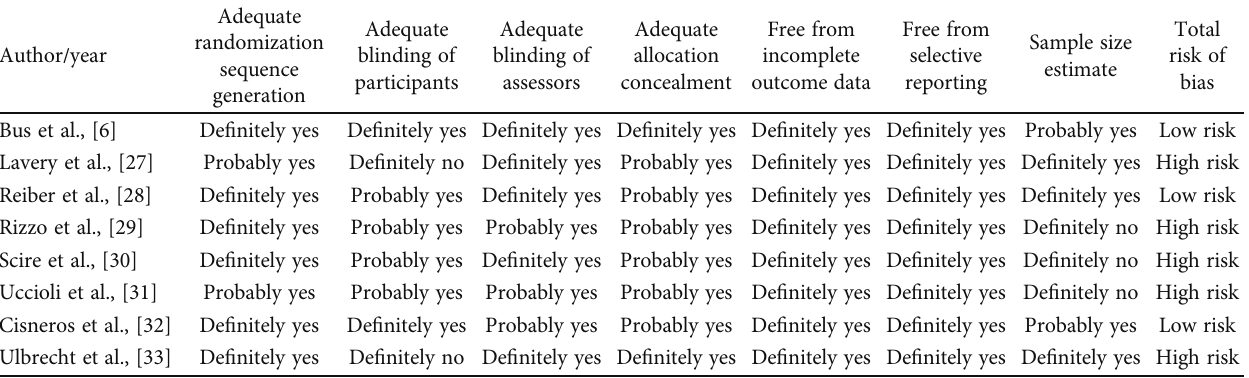
Table 2: Risk of bias of included studies.